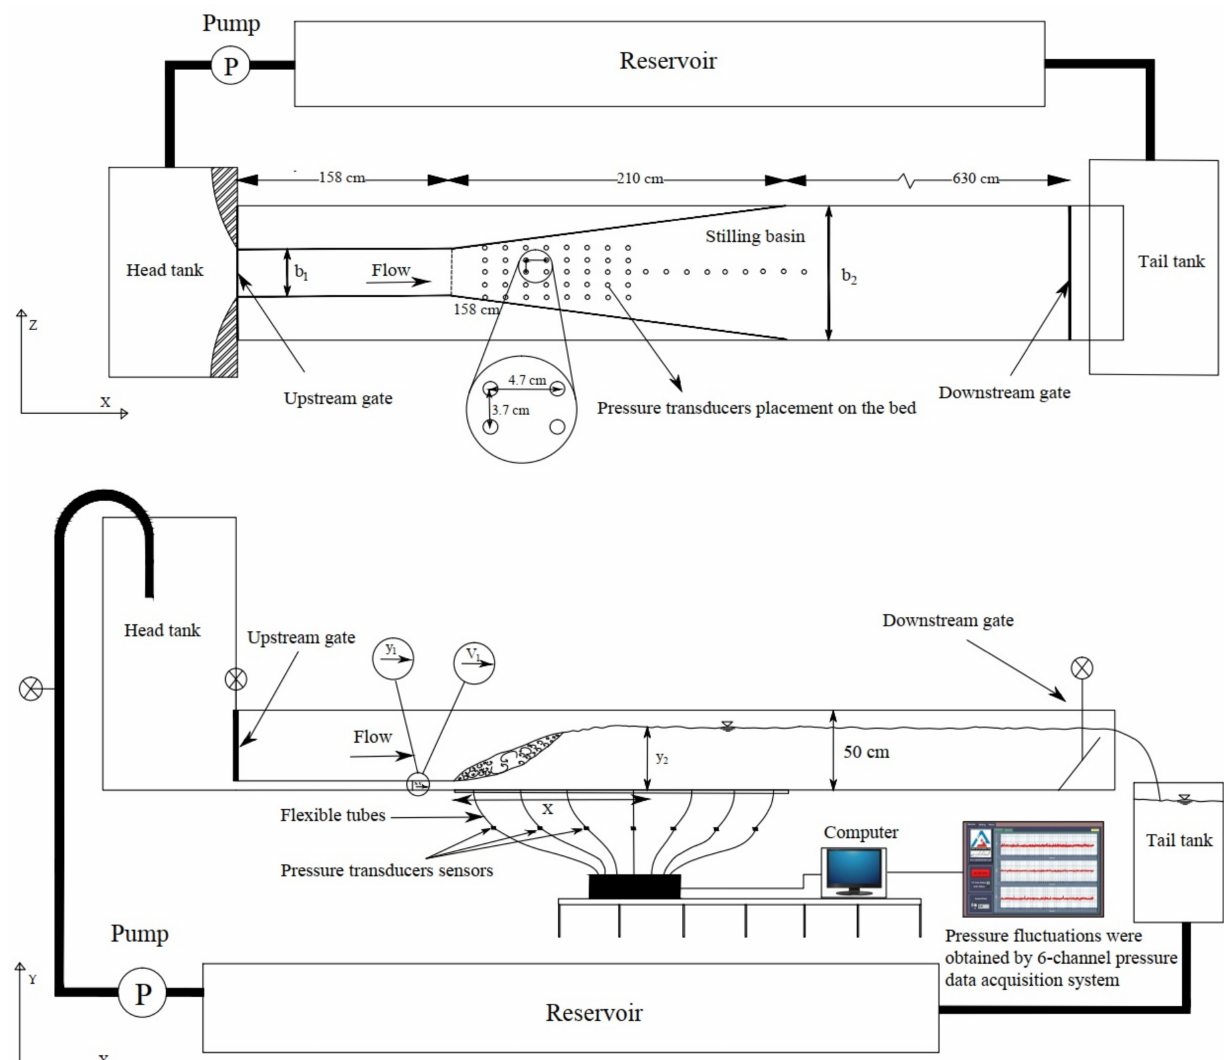
Figure 1. Plan and side view of the experimental setup with instruments. The flow discharge was measured by an ultrasonic flow meter model Transit Time Clamp-on located in the supply line. The inflow conditions were controlled by a vertical sluice gate that was rounded undershoot to induce a horizontal impinging flow without contraction. A sluice gate was placed at the end of the flume to control the position of the hydraulic jump toe. Four physical model setups were built (see Figure 2) with different expansion ratios ( B = b 1 / b 2 ) of 0.4, 0.6, 0.8, and 1 (where b 1 and b 2 are the widths of the stilling basin upstream and downstream of the spatial hydraulic jump,